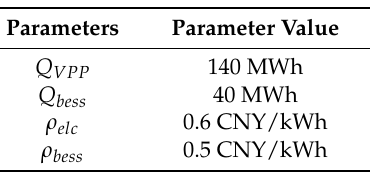
Table 1. Calculation parameters.